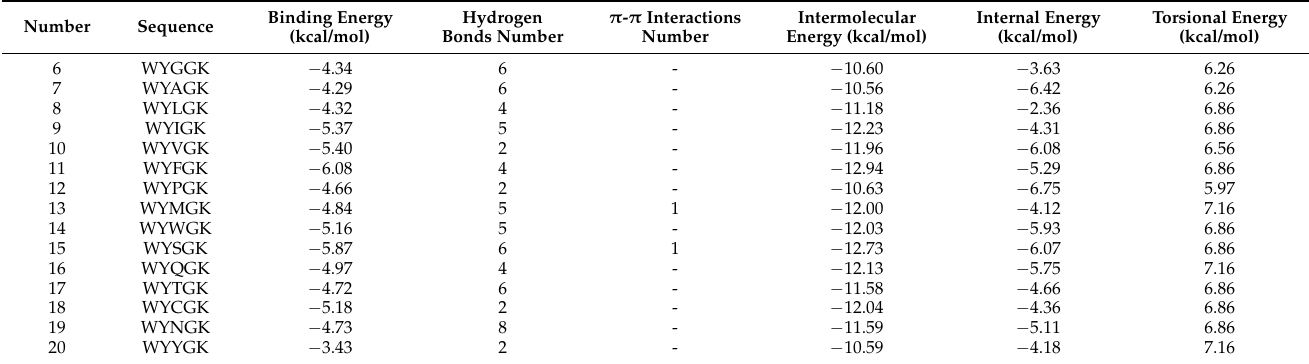
Table 1. Binding energy of pine nut-derived peptides docking with